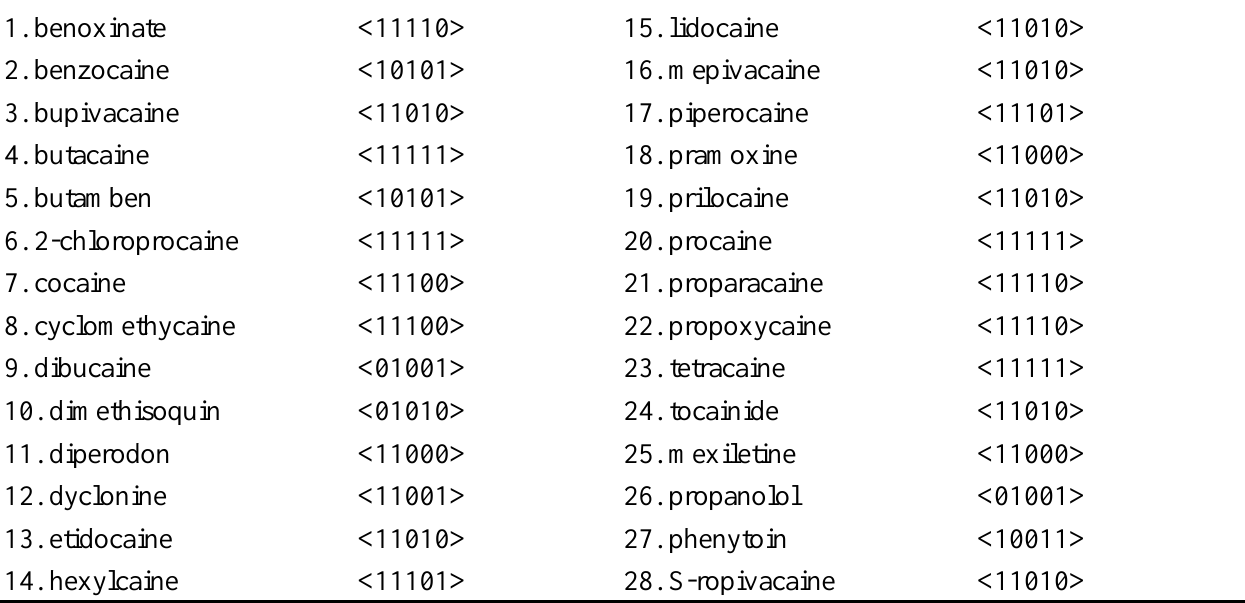
Table 1. Vector properties of local anaesthetics analogues of